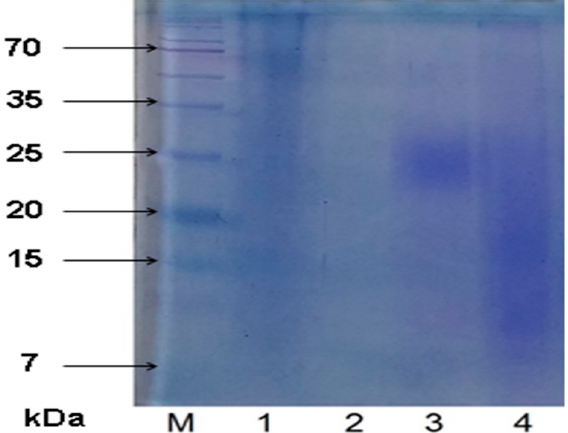
Figure 1. SDS-PAGE analysis of rose CPL. Lanes: M—standard marker; 1—CPL-Flos; 2—CPL-Lv; Figure 1. SDS ‐ PAGE analysis of rose CPL. Lanes: M—standard marker; 1—CPL ‐ Flos; 2—CPL ‐ Lv; 3— 3—CPL-H; CPL ‐ H; 4—CPL ‐ Fru.